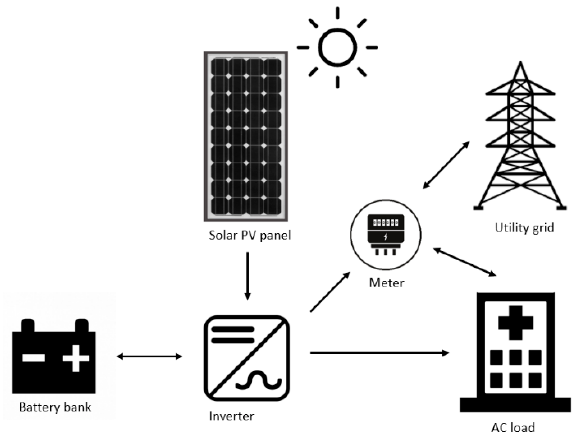
Figure 3. Solar PV system.